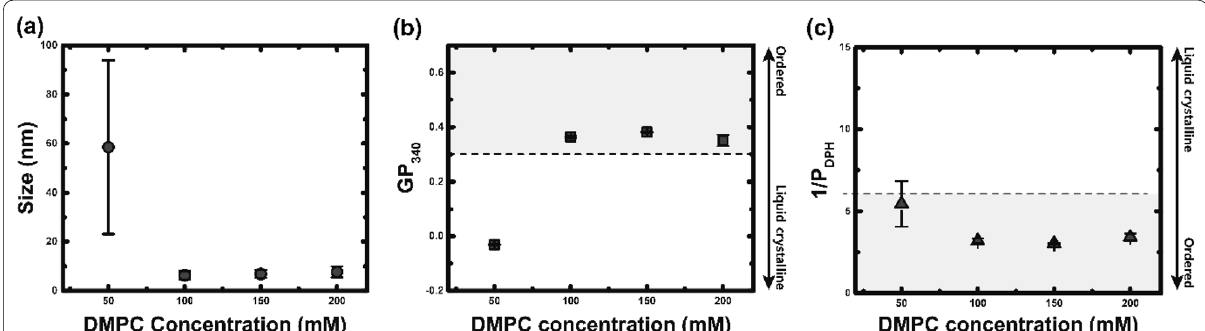
Fig. 2 a Size, b membrane polarity, c membrane fluidity of synthesized assemblies depending on DMPC concentration with 20 mM DHPC. Synthesis of lipid assemblies was performed at 20 °C using the microfluidic chip. The values and error bar indicate the mean values and standard deviation of measured data, respectively. The borderline of the membrane rigidity was adjusted based on the membrane properties of